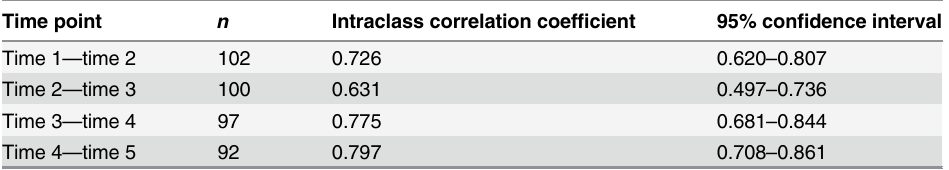
points are provided in Table 4. MSWS-12 scores correlated more strongly with measures of physical function (PDDS, MSIS-29 PHYS) than with the measure of psychological function (MSIS-29 PSYCH). Table 3. Estimates of test-retest reliability for MSWS-12 scores across successive 6-month time peri- ods in the sample of patients with